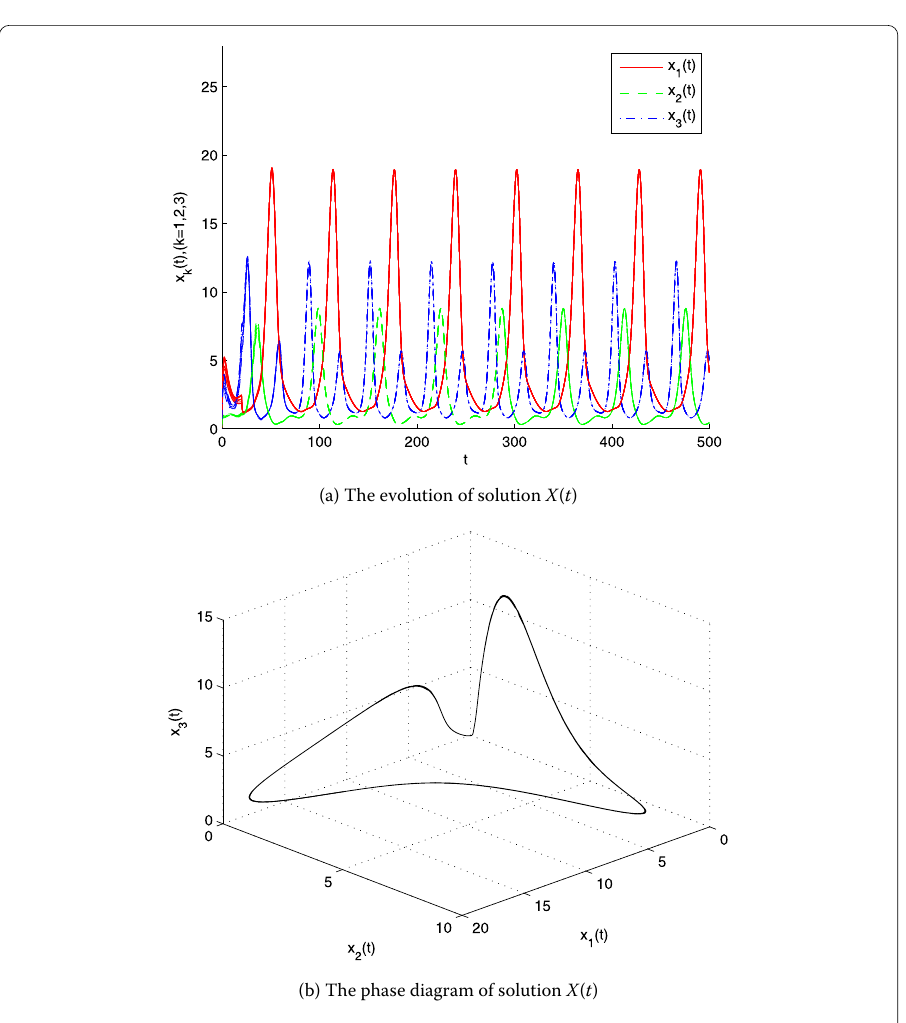
Figure 1 The asymptotic stability of the unique periodic positive solution of equation